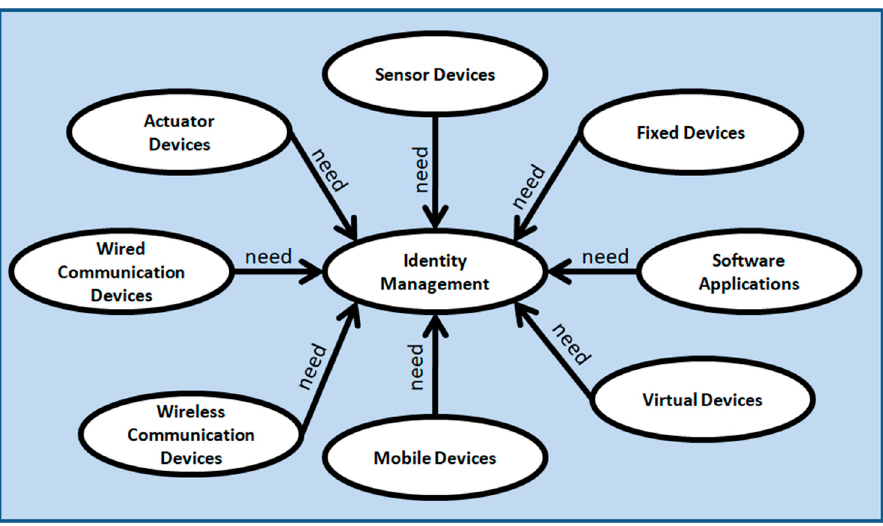
Figure 5. Identity management of IoT entities visualized as a semantic network.